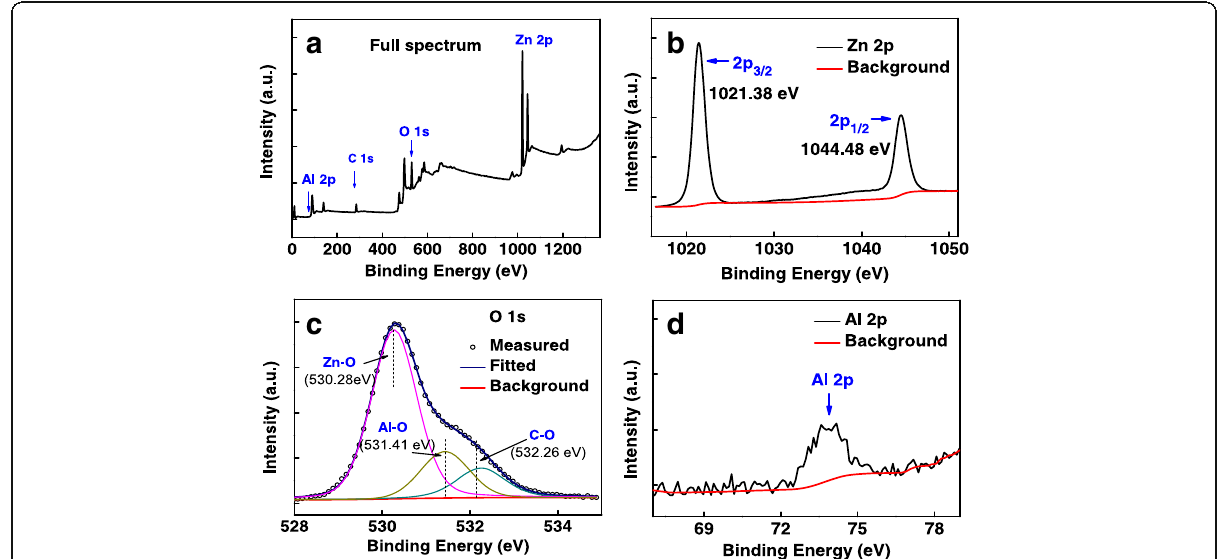
Fig. 4 The XPS spectra of 0.12 M AZO nanospears, a full spectrum, b Zn 2p, c O 1s, and d Al